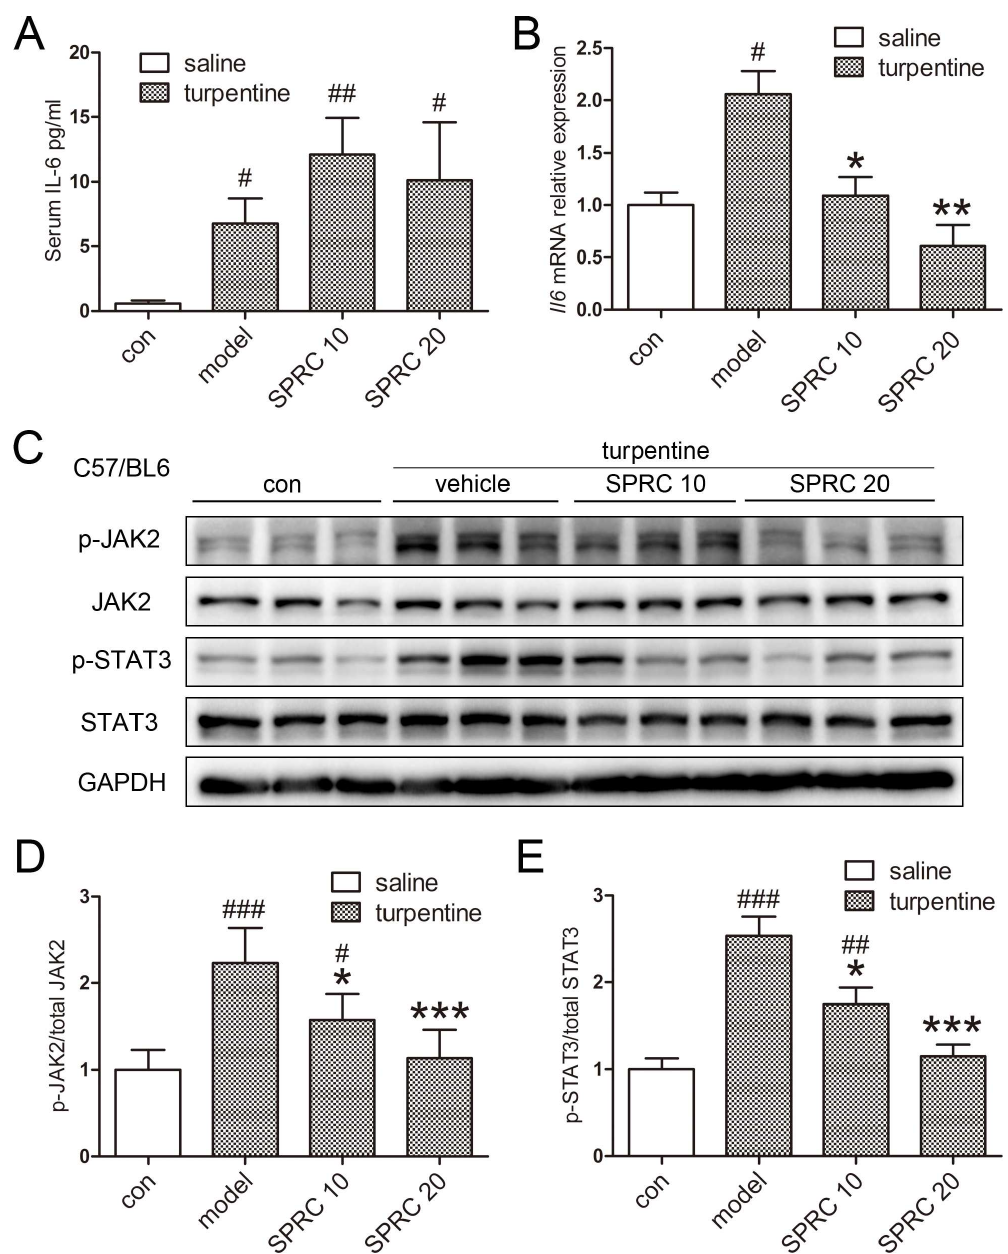
Fig 4. SPRC improved AI by reducing hepatic IL-6/JAK2/STAT3 activation. (A) Serum IL-6 content was not significantly changedby SPRC (n = 7). (B) Hepatic Il-6 mRNA levels were suppressedby SPRC, though only 2-fold change was observed in the model group (n = 7). (C) SPRC successfully ameliorated hepatic JAK2/STAT3 phosphorylation in the turpentine model. (D-E) Densitometry analysis of Fig 5C. Representative immunoblots are presented.Whole uncroppedimages of Fig 4C are shown in S2 Fig. Data are presented as the mean ± SEM. # p < 0.05, ### p < 0.001 compared with the control group; * p < 0.05, ** p < 0.01, *** p < 0.001 comparedwith the model